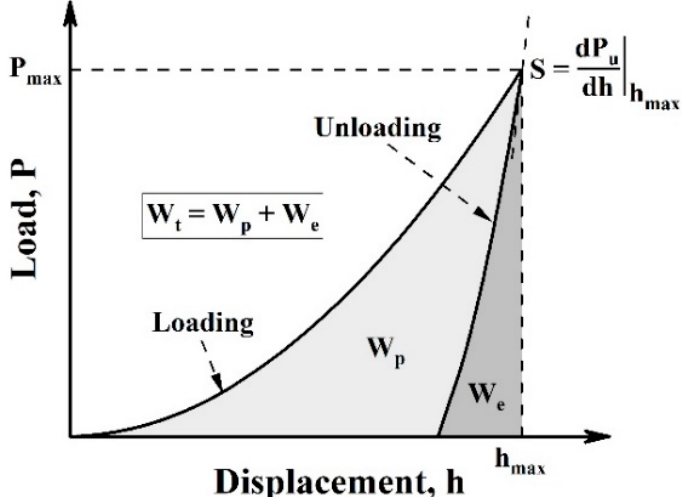
Figure 1. Illustration of a complete load–displacement